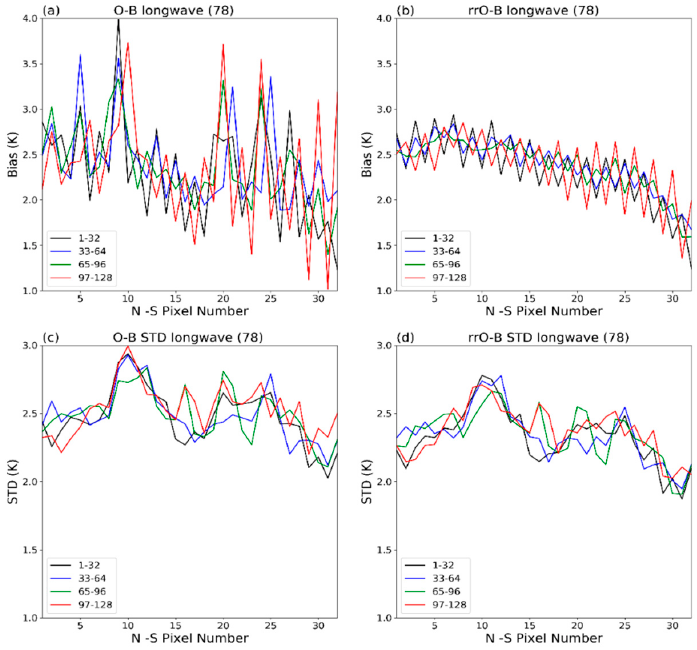
Figure 10. ( a ) Background departures (O-B); ( b ) reconstructed background departures (rrO-B); ( c ) standard deviations of the background departures (O-B); and ( d ) standard deviations of the reconstructed background departures (rrO-B) of channel 78 changes with the number of detection